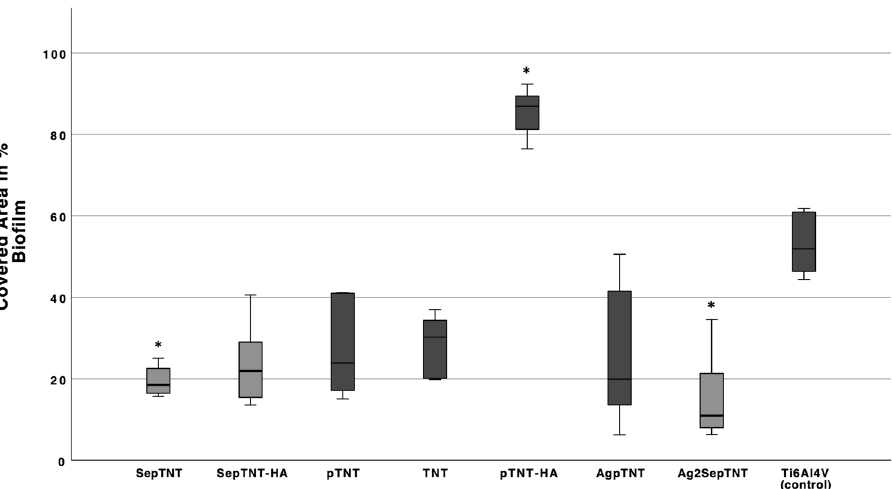
Figure 5. Biofilm coverage of modified and non-modified titanium discs. Selenium- and silver-selenium incorporated phosphate-doped TiO 2 -nanotubes (SepTNT, Ag 2 SepTNT) showed a significant reduction in biofilm formation whereas hydroxyapatite-coated discs with phosphate-doped TiO 2 -nanotubes showed an increased biofilm formation compared to the non-modified control.